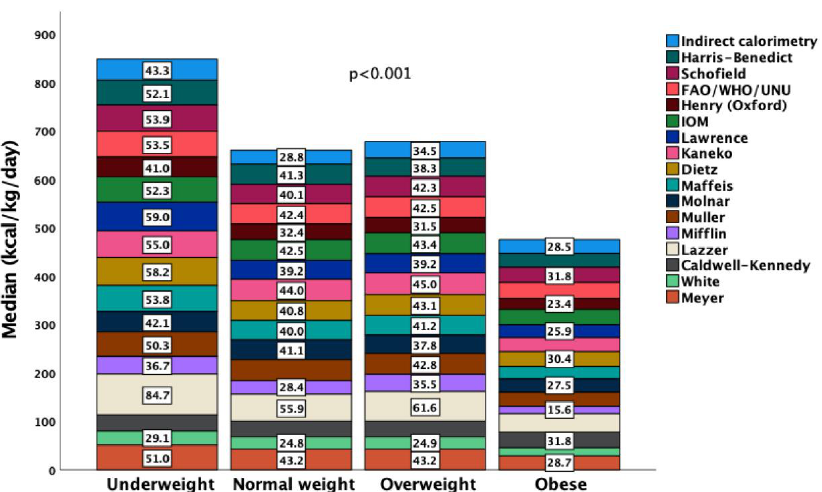
Figure 3. Measured by indirect calorimetry resting energy expenditure (REE IC ) (kcal/kg/day) was higher in the underweight and lower in the obese compared to other sub-cohorts ( p = 0.017). All predicted equations also calculated higher kcal/kg/day in the underweight compared to overweight and obese patients ( p < 0.001). Numbers in the white boxes indicate the medians of the equations. Paired eREE-REE IC differences did not differ among malnutrition groups for most predicted equations, apart from the Mifflin ( p = 0.016), Caldwell–Kennedy ( p = 0.039), Meyer ( p = 0.042), and RDA ( p < 0.01) equations (Figure 4).